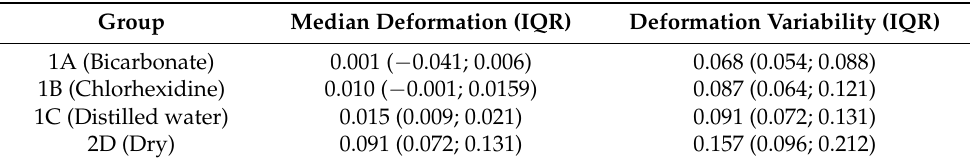
Table 3. Median deformation and deformation variability (mm).